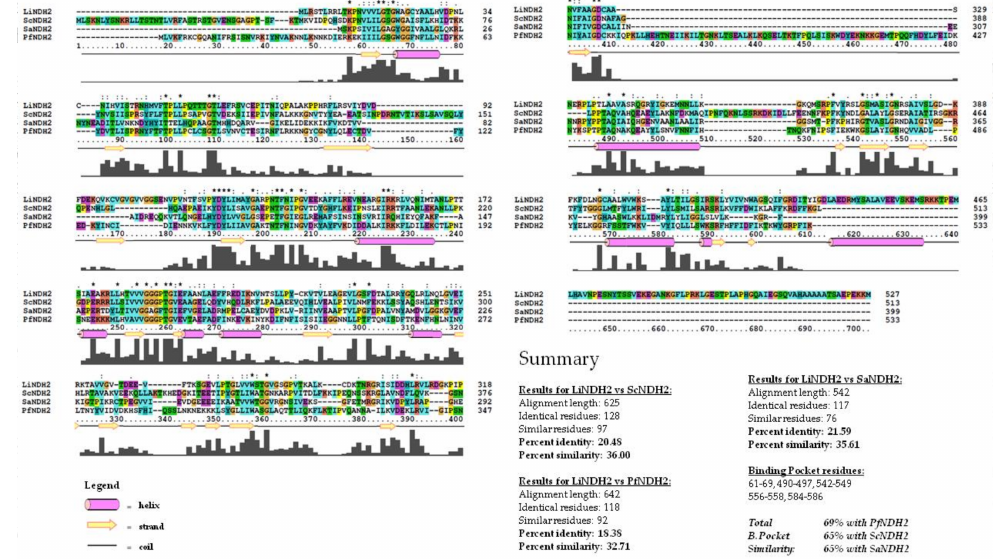
Figure 2. Sequence alignment of query (model– Li NDH2) and important template sequences: Sc NDH2, Pf NDH2 and Sa NDH2. Secondary structure prediction within alignment was generated using PSIPRED